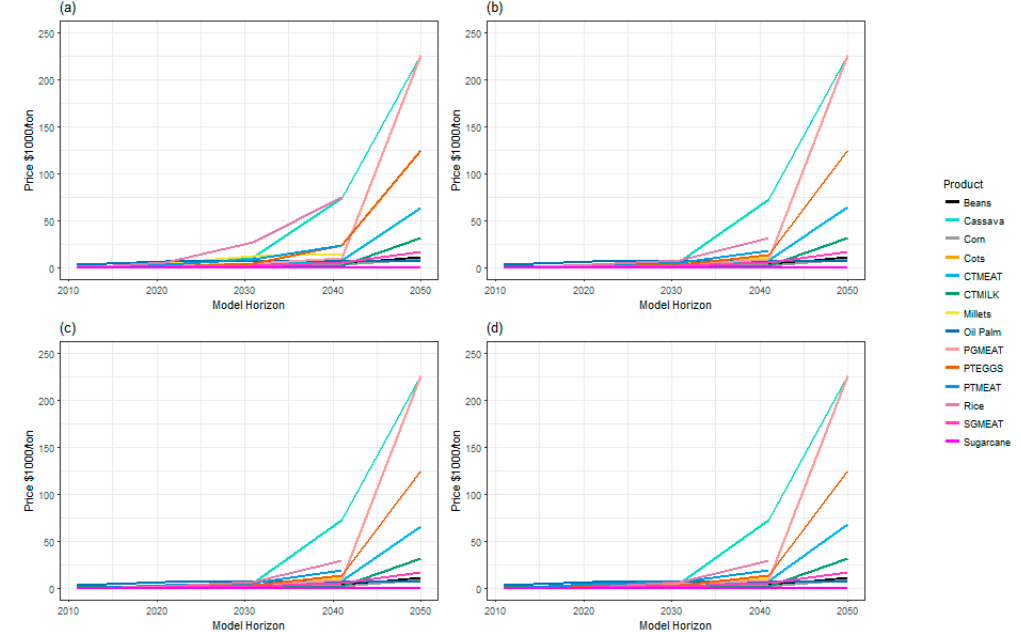
Figure 16. Agricultural product prices: ( a ) Baseline; ( b ) $40 carbon tax; ( c ) $80 carbon tax; ( d ) $120 carbon tax, under subsidy action.